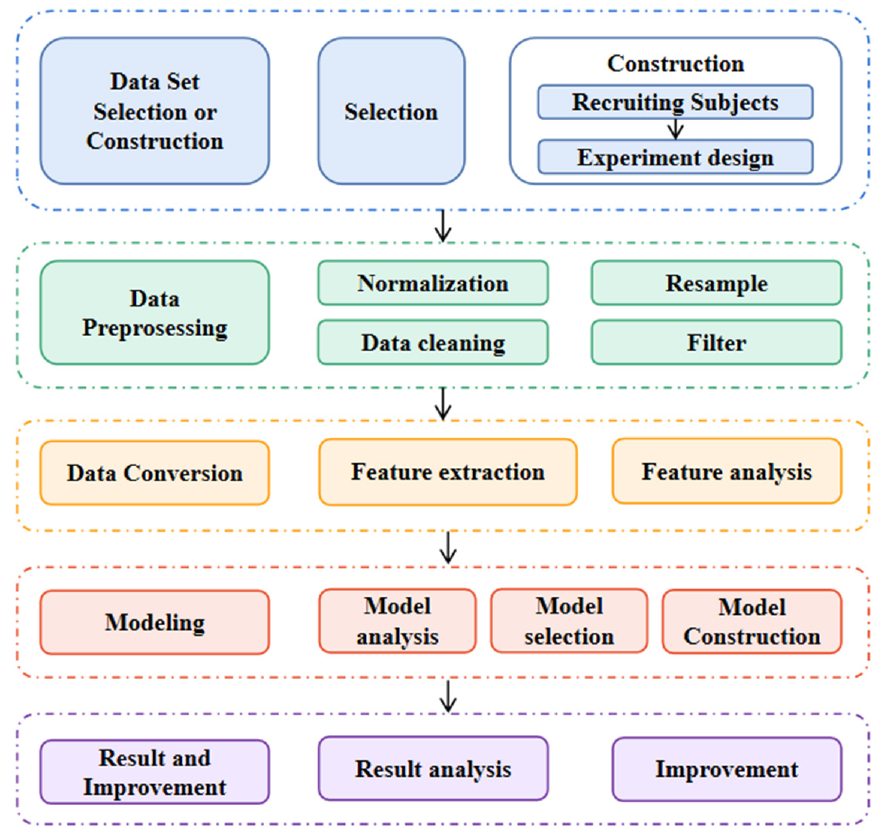
Figure 1. The process of data mining.